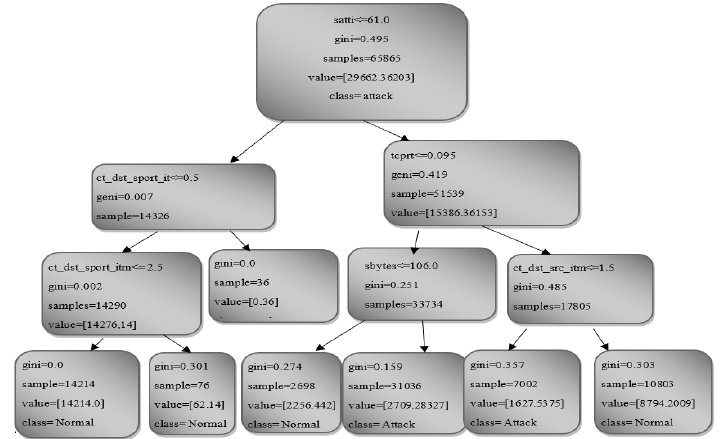
Figure 3. The tree structure-based framework (OGBDTs).